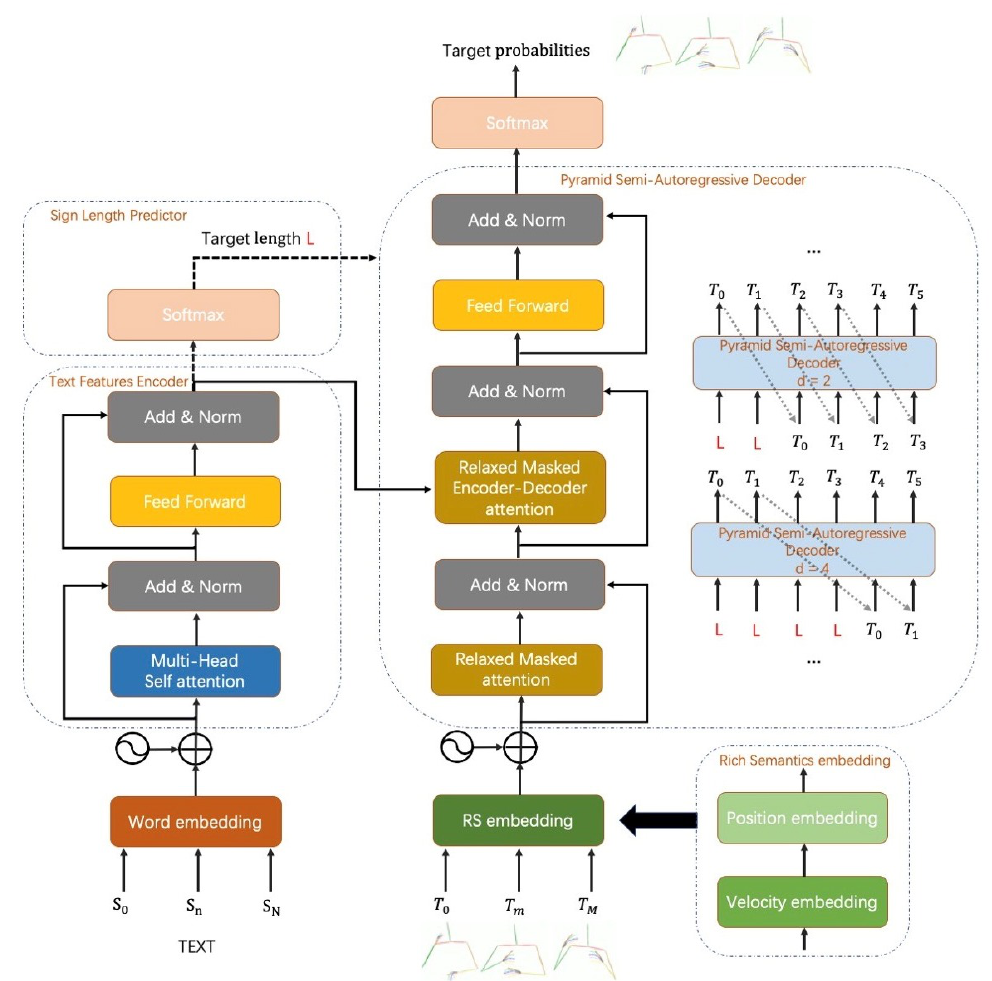
Figure 1. The overall architecture of PSAT-RS, which composes of a text feature encoder with sign length predictor and a pyramid semi-autoregressive decoder with RS